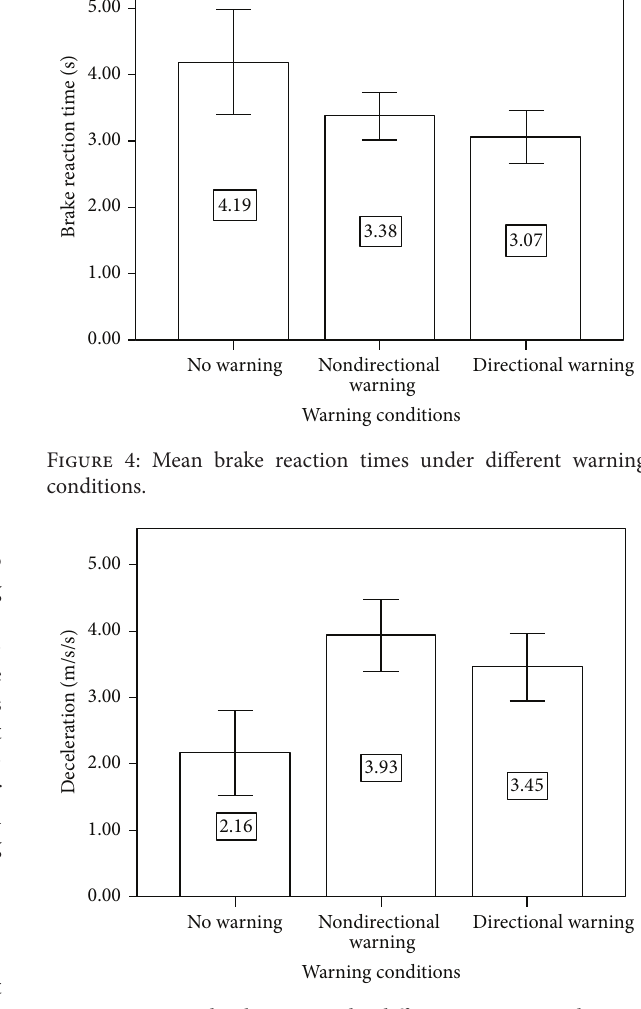
Figure 5: Mean deceleration under different warning